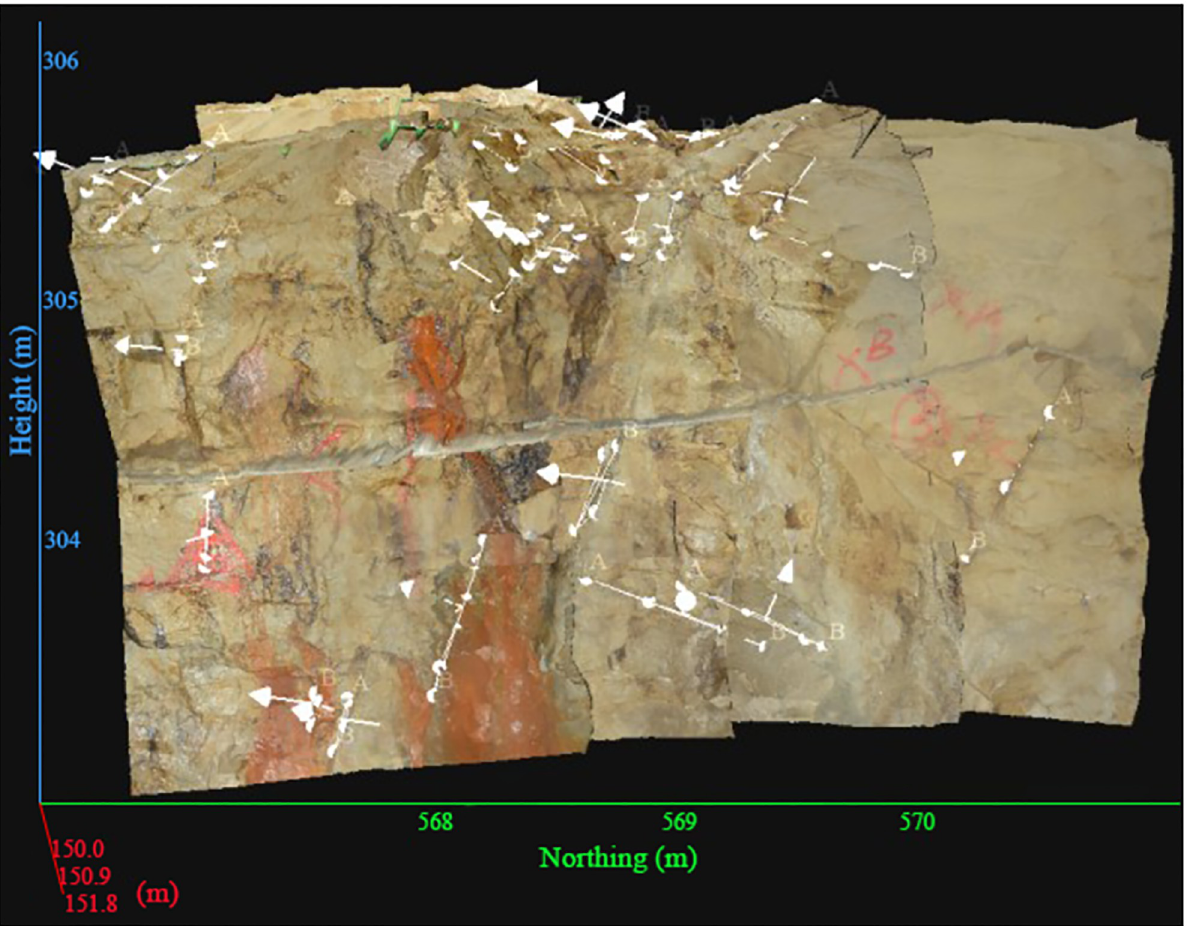
Fig 11. Drawing of rock mass structural plane of measuring point in the -570m level by Sirovision.